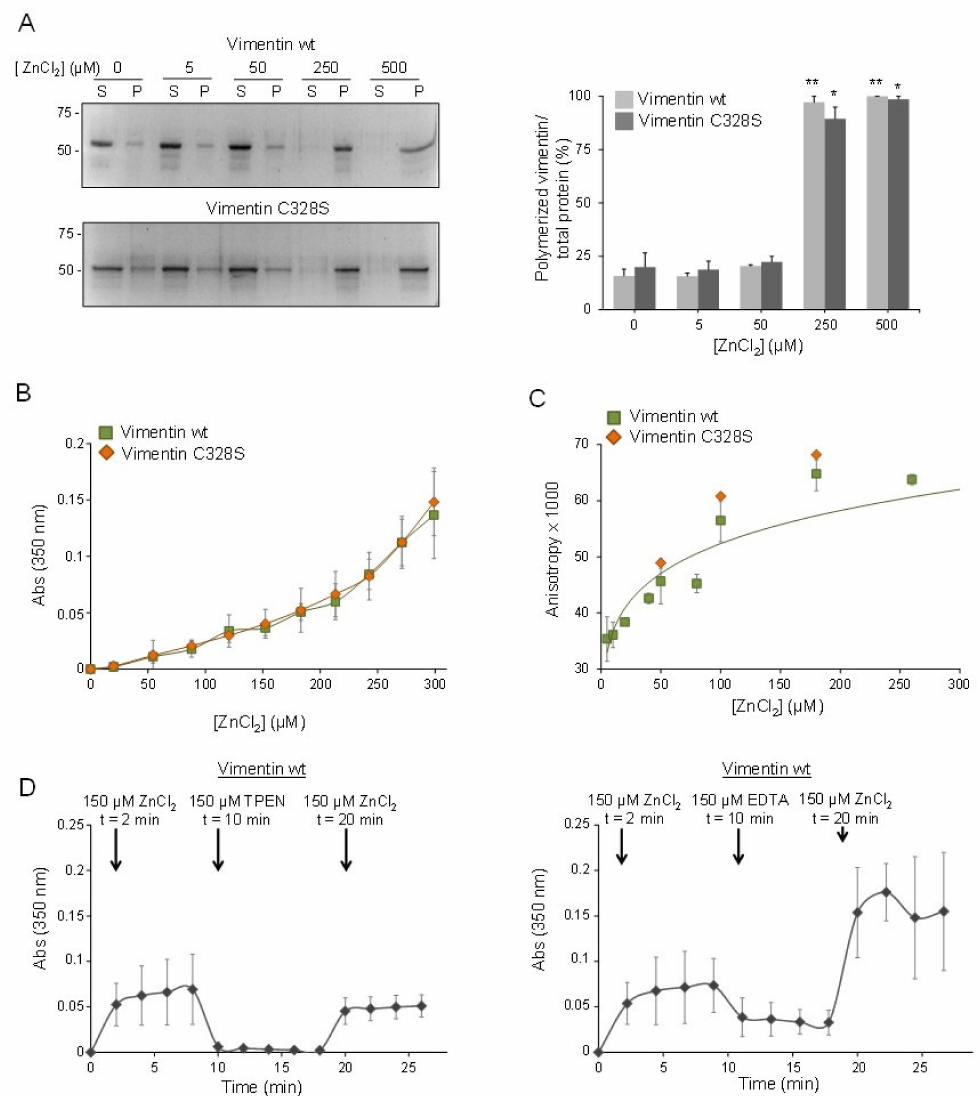
Figure 2. E ff ect of micromolar zinc concentrations on vimentin oligomerization assessed by centrifugation and turbidity assays. ( A ) Vimentin wt or C328S was incubated with the indicated concentrations of ZnCl 2 for 1 h at r.t., and the formation of insoluble oligomers was assessed by ultracentrifugation as above. Gels shown are representative of three assays. The proportion of polymerized vimentin, i.e., present in the pellet fraction, was estimated by image scanning, and results corresponding to the mean ± SEM of three assays are depicted in the graphs. ** p < 0.005, and * p < 0.05 vs. the corresponding construct in the absence of zinc. ( B ) Vimentin wt or C328S was incubated with increasing concentrations of ZnCl 2 , and the turbidity of the solution, assessed as the absorbance at 350 nm at r.t., was measured immediately. Results are the mean values ± SD of at least three experiments. ( C ) Mixtures containing 1 µ M unlabeled vimentin and 50 nM Alexa 488-labeled vimentin were incubated with increasing concentrations of ZnCl 2 , and fluorescence anisotropy was monitored at 26 ◦ C. Results are the mean ± SD of eight (vimentin wt) or two replicates (vimentin C328S). ( D ) Reversibility of zinc-induced vimentin aggregation upon addition of TPEN (left) or EDTA (right). Vimentin was sequentially incubated with ZnCl 2 , TPEN, or EDTA and, then, ZnCl 2 again at r.t., at the concentrations and time-points indicated. Results are average values from three independent experiments. Lines in the graphs are only meant to guide the